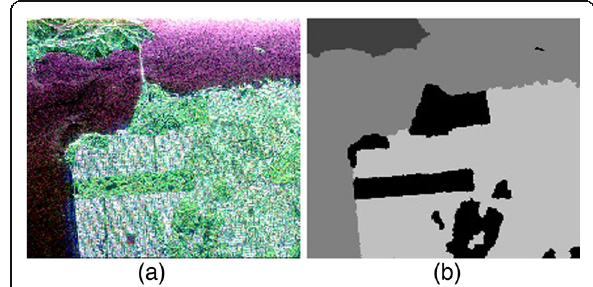
Fig. 9 San Francisco Bay image. a Sinclair decomposition. b Hand segmented image